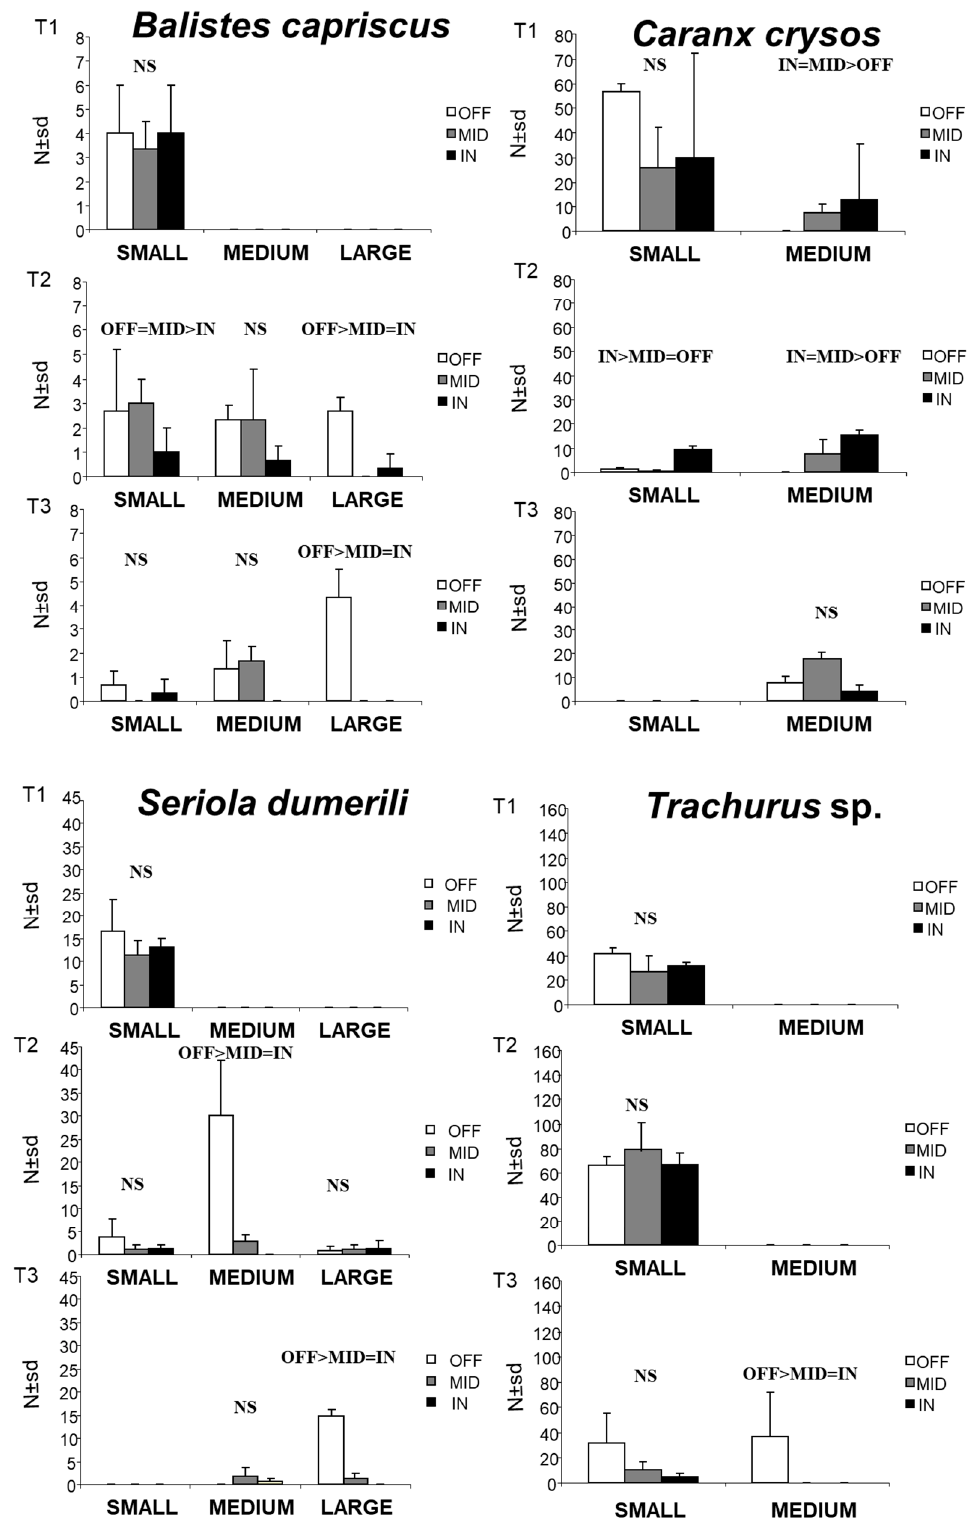
Figure 3. Mean ± sd (standard deviation) of the individual species at the OFF, MID, and IN distances (offshore, mid-shore, inshore) separated for the three periods (T1, T2, T3) and for the three fish size classes: small (up to 10 cm), medium (10.1 to 14 cm), large (greater than 15). The results of pairwise comparisons (SNK test; NS = not signi fi cant) are also reported.